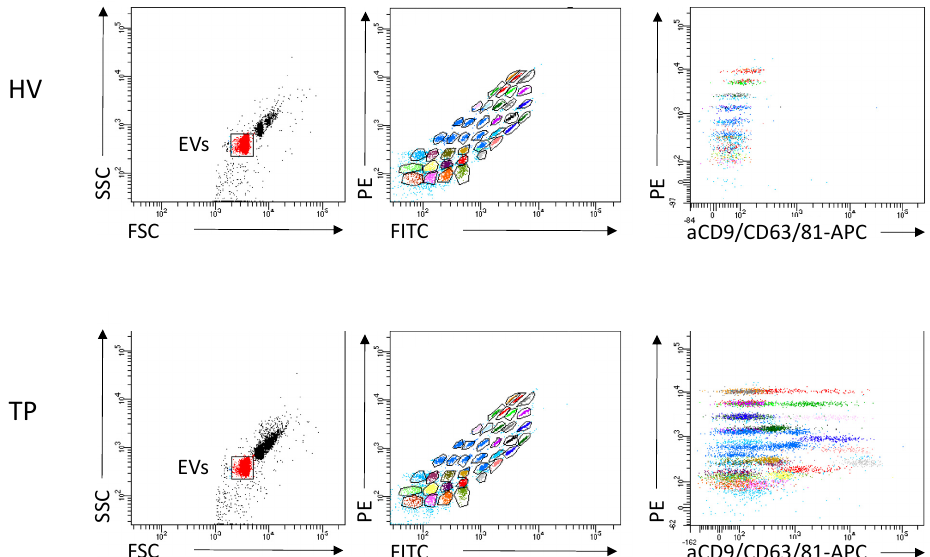
Figure 3. Representative flow cytometric gating strategy for extracellular vesicles (EVs) is shown for healthy volunteers and tumor patients (TP). Analysis examples show exclusion of doublets and no bead events, ( left ) discrimination of differently labelled bead populations ( middle ), and measurement of signal intensities of the single bead populations ( right ). The positive bead populations are highlighted in colours.